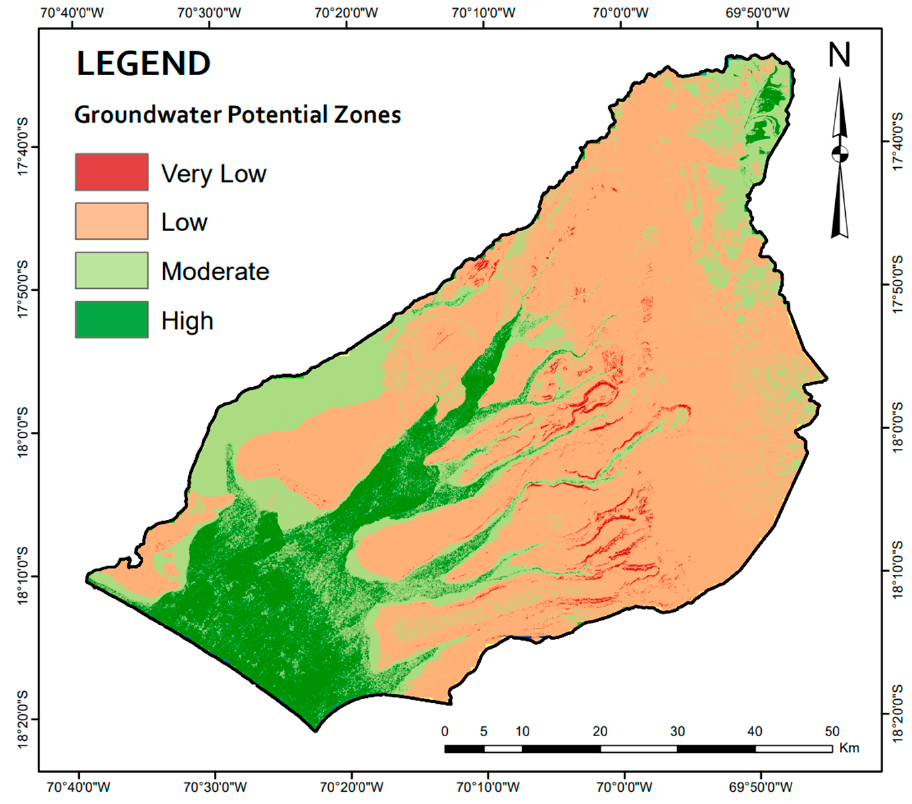
Figure 5. Groundwater potential zones map.